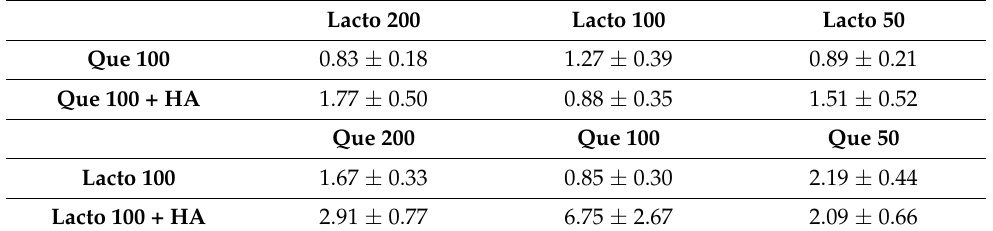
Table 1. The values ( C syn ) are the result of the mathematical analysis used to determine the com- bination and concentrations of Que and lacto, with the best synergistic antimicrobial activity. The combination of HA–Lacto–Que (100 ppm w / v ) showing the best synergistic C syn values.